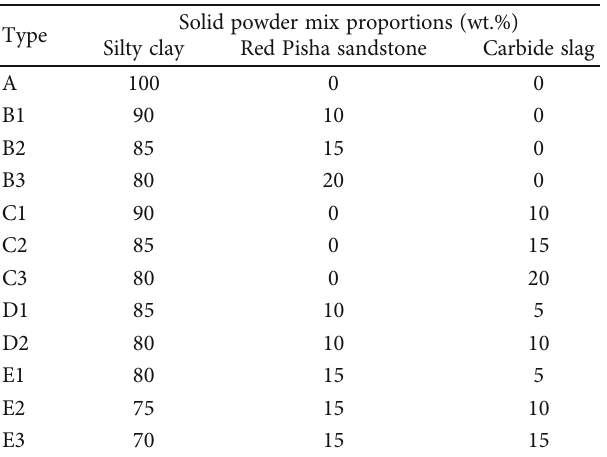
Table 2: Mix proportion of the test materials